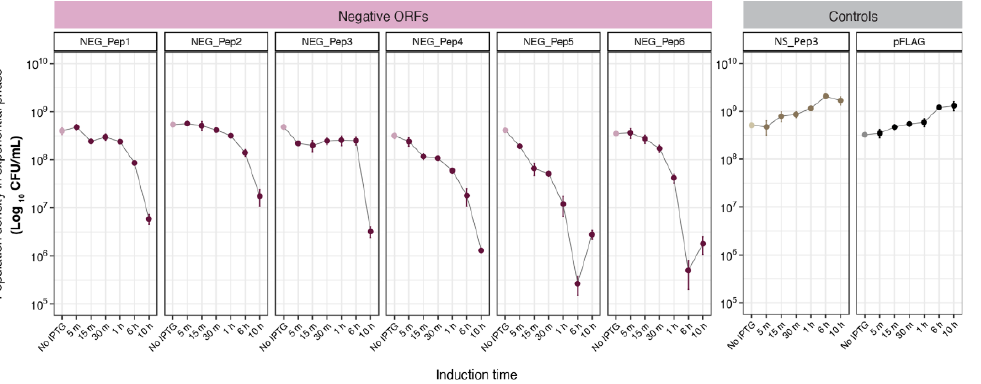
Figure 3. Test for the viability of cells after NEG_Pep induction. Colony counts (CFU/mL) of bacteria in the log phase, expressing either negative, non-significant or pFLAG peptides at different times after IPTG addition, show a decline in the NEG_Pep strains. Growth of the NS_Pep and pFLAG controls, on the other hand, is not affected by IPTG induction. Each panel’s light color dots represent growth under no induction, followed by IPTG addition (darker dots). Three replicates were done for each time point; whiskers in each dot represent SD.